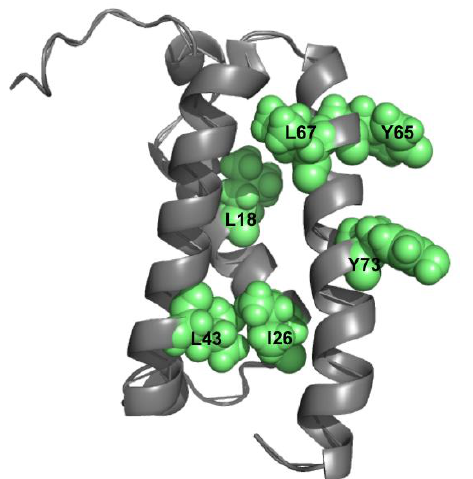
Figure 2. Structural distribution of residues L18, I26, L43, Y65, L67, and Y73 (green spheres) in the KIX domain (PDB 2AGH). The analysis of folding m values, in combination with double mutant cycle analysis, allowed to characterize, from a thermodynamic perspective (i.e., measuring ∆∆∆ G values), the role of these residues in stabilizing non-native interactions in the denatured state of KIX. With the exception of I26 and L43 that are in direct contact, residues displaying significant coupling free energies are located in different regions of the domain (see [28] for details).